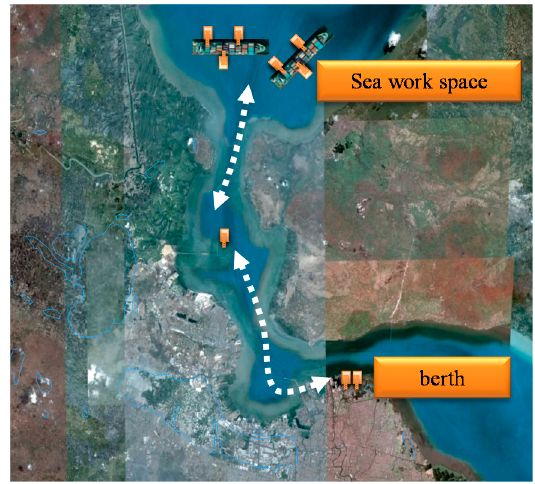
Figure 4. Layout of the Surabaya port.